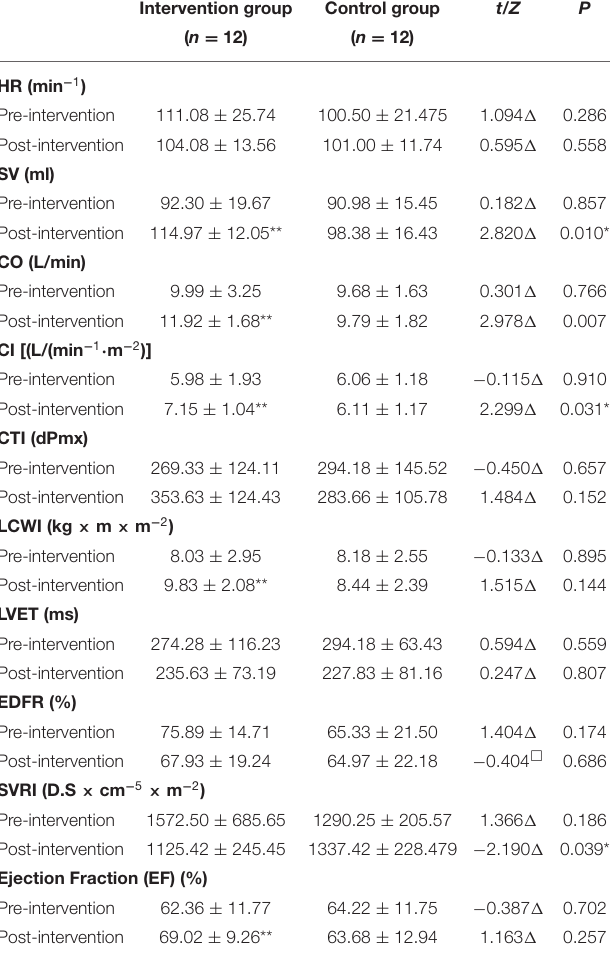
Intervention group Control group